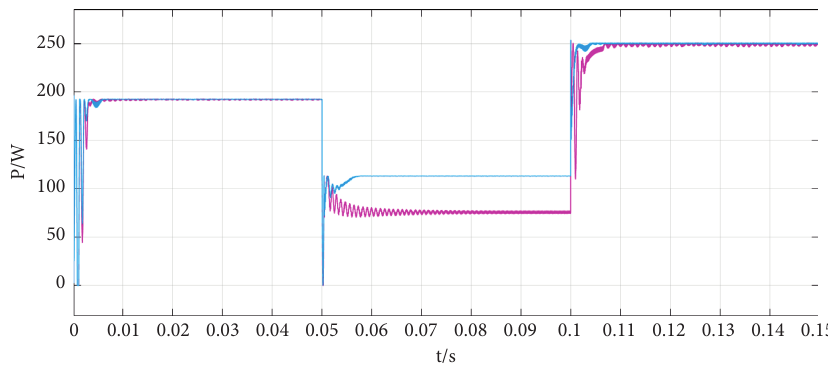
Figure 11: Simulation